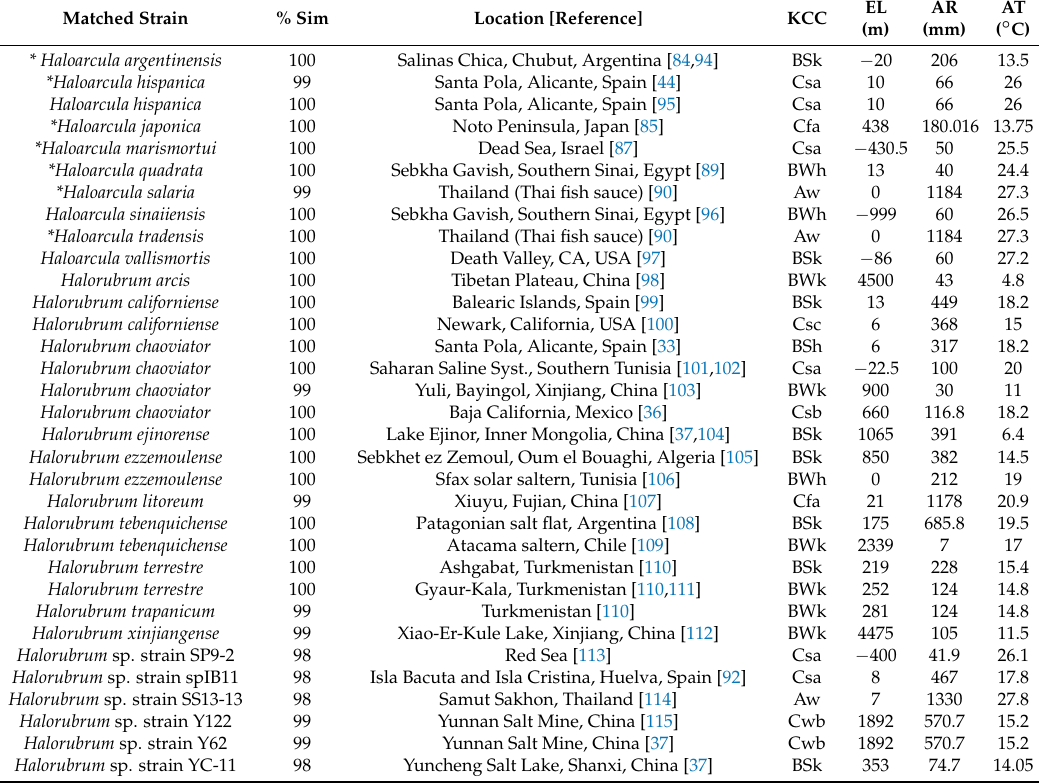
Table 2. Halophilic archaea isolates cultured from Great Salt Lake shore halite crystals. For each isolated cultivar, we have listed the closest-matched species/strain and percent similarity (% Sim) in the partial 16 S rRNA gene sequence. For the sampling sites of matched strains, we have indicated the geographic location and reference for the study, Köppen Climate Classfication (KCC) [74], EL, Elevation Level (EL) in meters above sea level; Average Rainfall (AR), and Average Temperature (AT). DNA